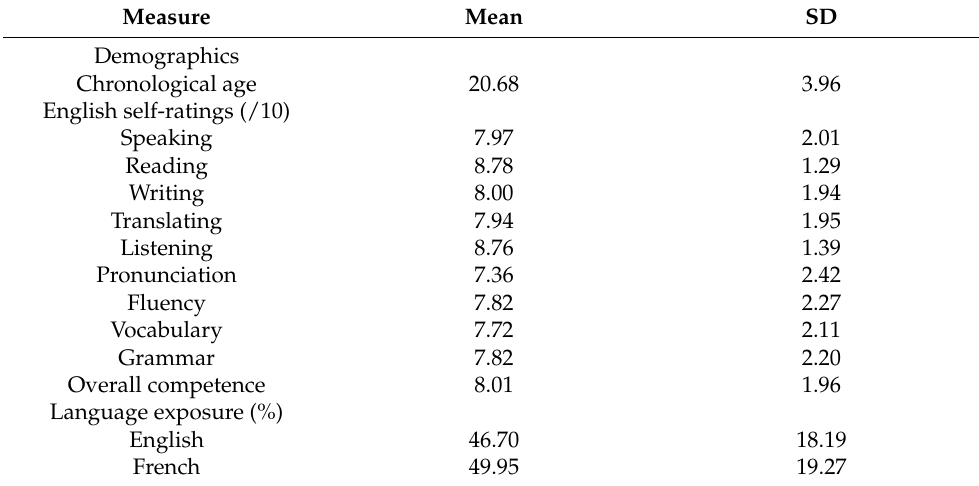
Table 1. Participant characteristics (Experiment 1). Self-ratings were collected on a 1–10 scale (/10).